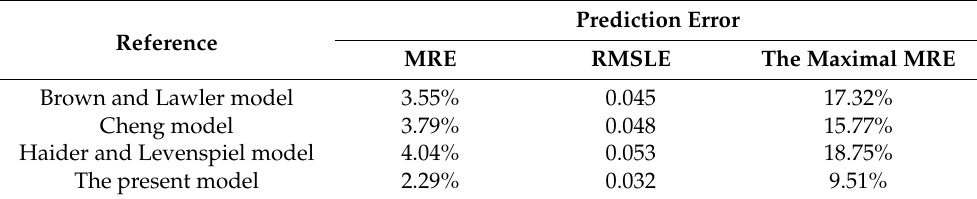
Figure 9. ( a – d ) Comparison between the measured and predicted drag coefficients of different models for a sphere settling in Newtonian fluid. Table 3. Error statistics of the drag coefficient of spherical particle.